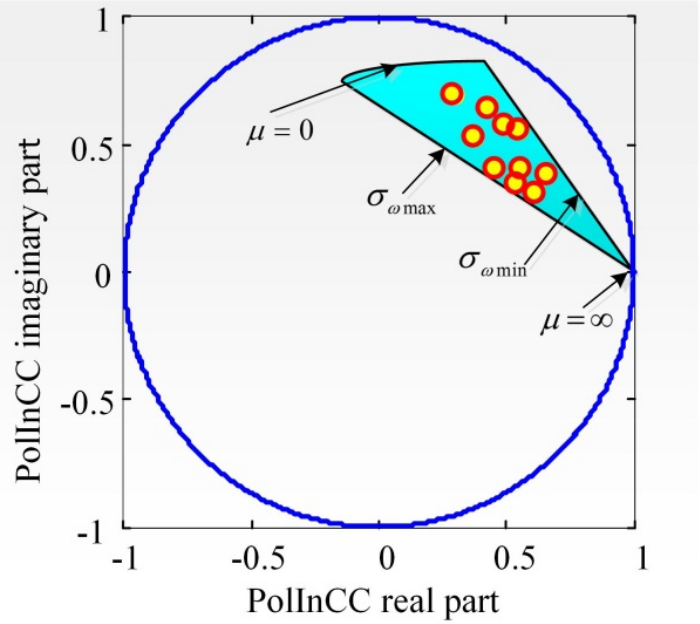
Figure 3. Distribution area of PolInCCs, considering polarization characteristics. When the maximum and minimum extinction coefficients in the PolInCCs and the ground phase point in the forest are determined, two curves in the complex unit circle can be obtained on the basis of the relationship between the extinction coefficient σ ω and the tree height h v in the VCC. An approximate quadrilateral coherence coefficient distribution area can be determined by combining the two boundaries of the coherence coefficient distribution area under different polarization states. In this distribution area, the VCC is considered as the effective VCC in the forest under different polarization states. Then the ground phase is removed from the effective VCC. After that, the VCCs in this area are compared with LUT to obtain a set of height values, and the final forest canopy height can be obtained by calculating the average. Figure 4 shows the distribution range of the effective VCC. The pink approximately quadrilateral area in the figure is the distribution area of the effective VCC, related to polarization characteristics. For the ground phase in the estimation of forest height in the X-band, the FS method is used to expand the distribution range of PolInCCs, and then the ground phase is obtained by means of the straight-line fitting method. It can be seen from the expression of the VCC that the determination of the maximum and minimum extinction coefficients requires a known forest height. In the VCC curve with the extinction coefficient as an independent variable, the maximum and minimum extinction coefficients can be found based on the intersection of the boundary line of the PolInCCs and the curve (at this time, the amplitude ratio of the ground to the volume is approximately 0). In practice, the forest height is unknown in the process of estimation. The maximum and minimum values of the extinction coefficient cannot be determined in advance. The research in the literature [43] shows that the extinction coefficient of a forest area above 10 m using X-band data is about 0.4 db/m. Therefore, we restricted the extinction coefficient range to σ ω = [ 0.2, 0.6 ] dB/m. The final forest height was calculated in the effective volume scattering region using the extinction coefficient in this